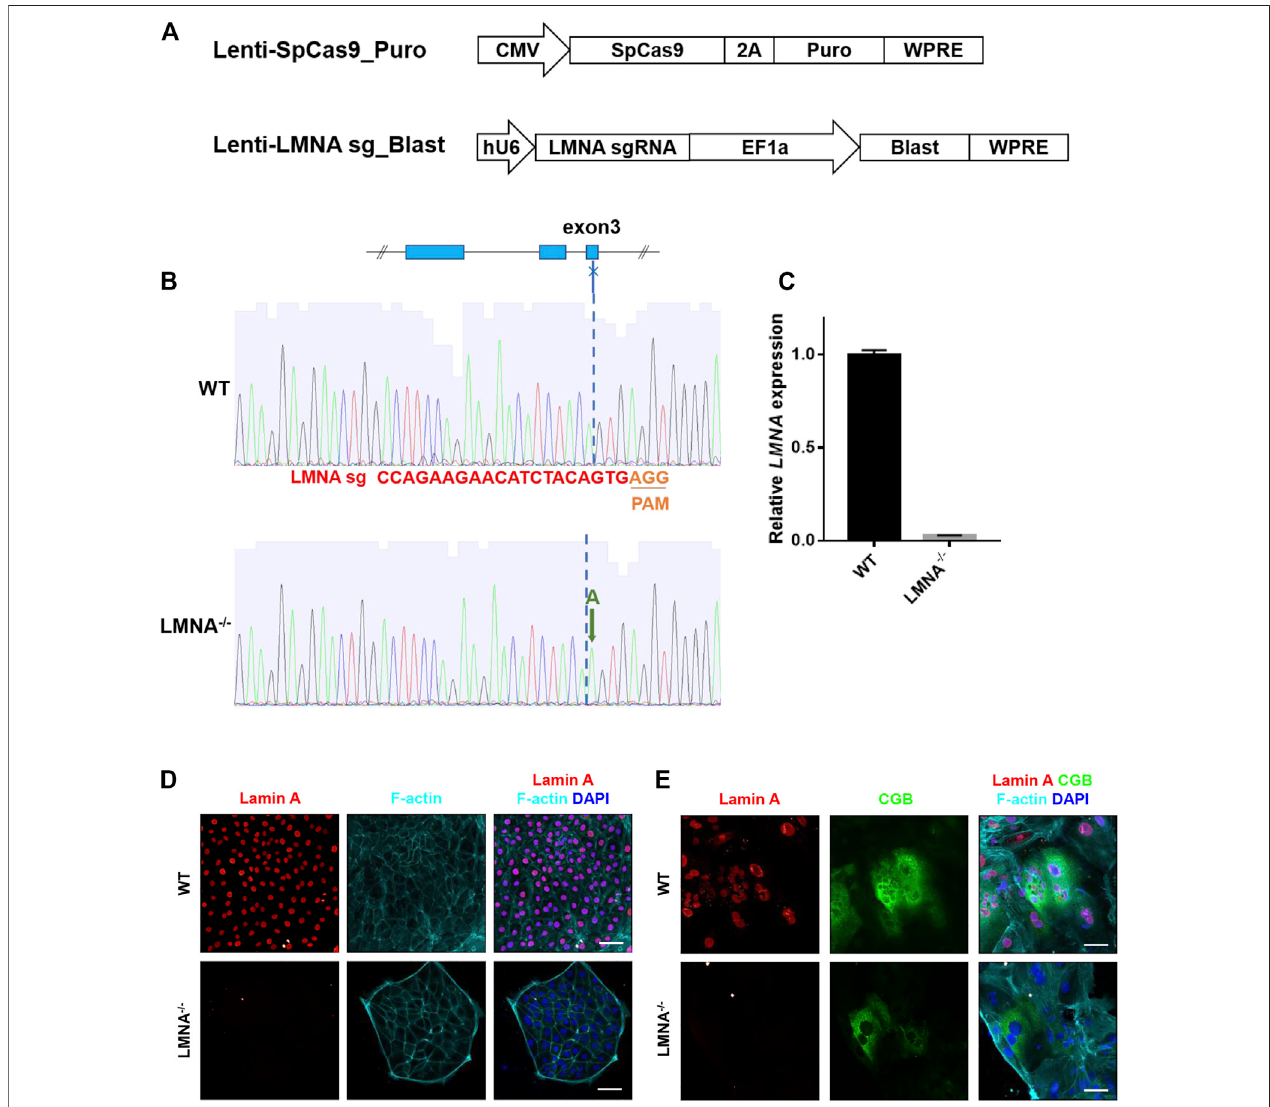
FIGURE 4 | Construction of LMNA − / − hTSCs. (A) The lentiviral vectors used for SpCas9 (the top penal) and LMNA sgRNA (the bottom panel) expression. CMV, human cytomegalovirus immediate early promoter; EF1a, elongation factor-1 α core promotor; hU6, RNA polymerase III promotor for human U6 SnRNA; 2A, 2A self- cleaving peptide; Puro, puromycin selection marker; Blast, blasticidin selection marker; WPRE, posttranscriptional regulatory element. (B) Sanger sequencing results of the LMNA sgRNA target site in wildtype (WT) and LMNA − / − hTSCs. The LMNA sgRNA used in this study targets to the third exon of LMNA gene. (C) qRT-PCR analysisofLMNA mRNAexpression in WT and LMNA − / − hTSCs. Graph showing theexpression level relativetothe geometric meanof thehousekeeping geneGAPDH. Data are shown as mean ± s.e.m. (D) Immunostaining of WT and LMNA − / − hTSCs for Lamin A and F-actin. DAPI, blue, DNA. Scale bars, 50 μ m. (E) Immunostaining of WT and LMNA − / − STB for Lamin A, CGB, and F-actin. DAPI, blue, DNA. Scale bars, 50 μ m.